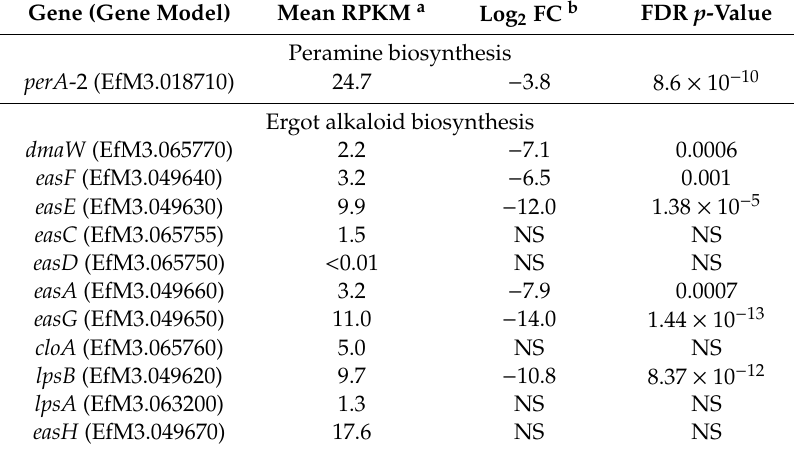
Table 8. Most Epichloë festucae alkaloid biosynthetic genes were more highly expressed in the asymptomatic inflorescence tissue than in the choke stroma